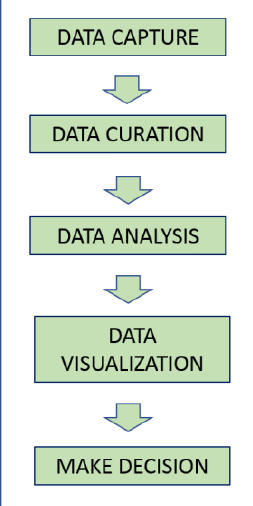
Figure 4. Workflow for decision making in Big data science.